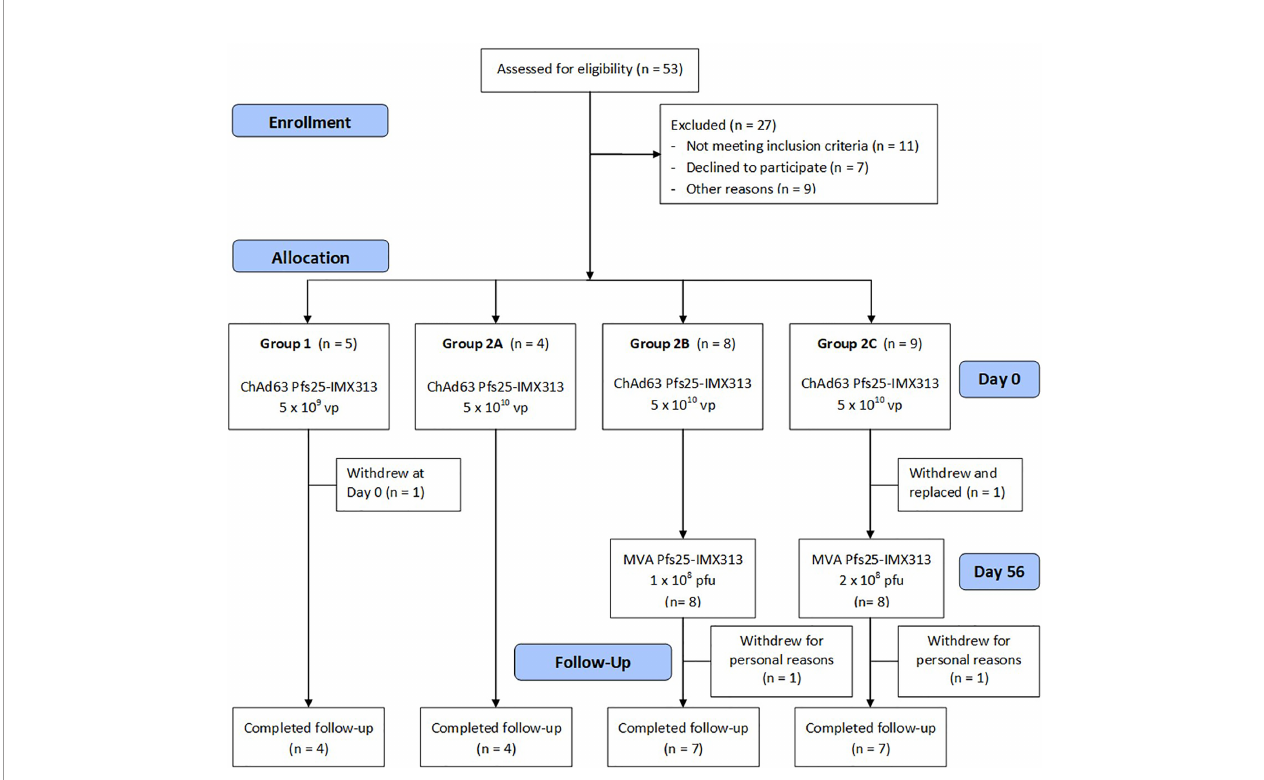
FIGURE 1 | VAC062 fl ow chart of study design and volunteer recruitment. The VAC062 study took place between October 2015 and May 2017. All immunizations were administered intramuscularly (IM) with sequential vaccines administered into the deltoid muscle of the non-dominant